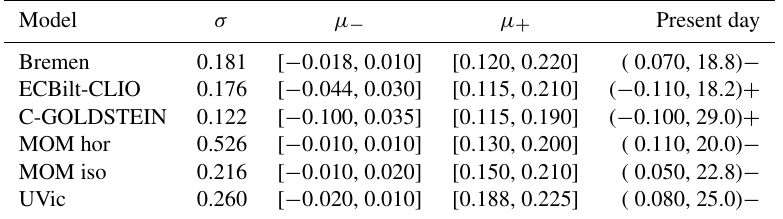
Table 2. Overview of models, the estimated standard deviation with the upper branch fitted to a linear function (note that the original trajectories had already been smoothed), the ranges of µ ± , the location of the present day in the models, and whether the present day value is in the unimodal regime ( + ) or not ( − ). All values are given in units of